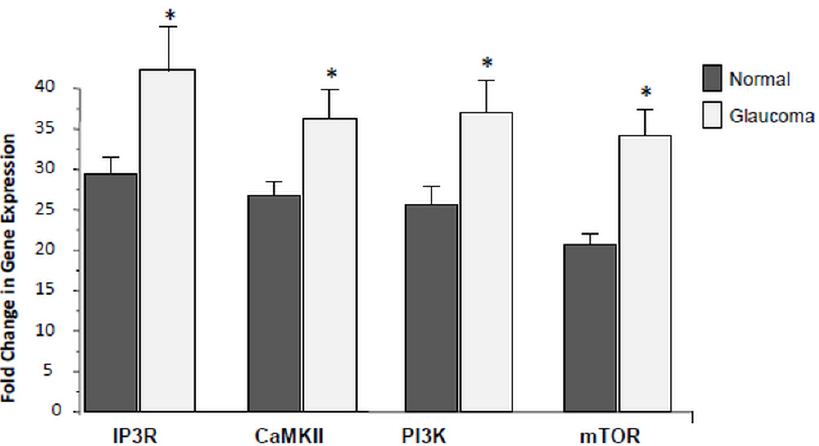
Figure 5. Transcription of IP3R, CaMKII, PI3K, and mTOR in normal and glaucoma LC cells. Average data of qRT-PCR comparing the transcription levels of IP3R, CaMKII, PI3K and mTOR in three 3 normal and 3 glaucoma LC cells. Note that transcription levels of IP3R, CaMKII, PI3K, and mTOR are all significantly up-regulated in glaucoma LC cells. Values which are significantly different to controls are denoted by asterisks (* p < 0.05 vs. Control). 18S is the housekeeping control gene. The experiments were performed and reproduced on 3 separate experiments on LC cells from 3 normal controls and from 3 glaucoma donors.